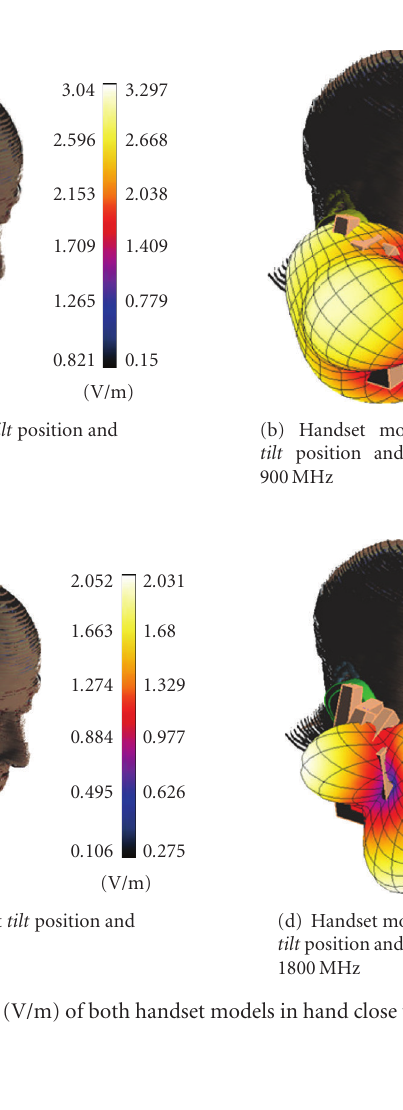
Table 5: The computed averaged peak-SAR (over 1g and 10g) and power absorption in tissues, radiated power, total loss, total isotropic sensitivity, and computation error for both handset models in hand close to head at di ff erent positions and at 900MHz. 900 MHz- Cheek